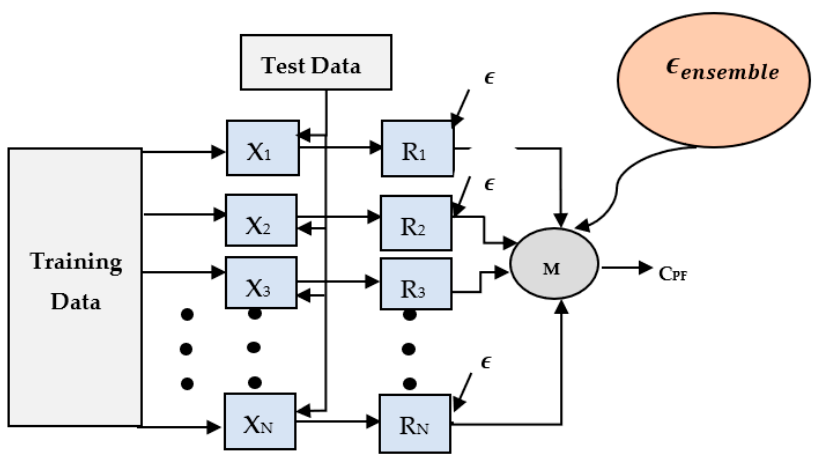
Figure 3. Error minimization using a number of base classifiers in an ensemble.